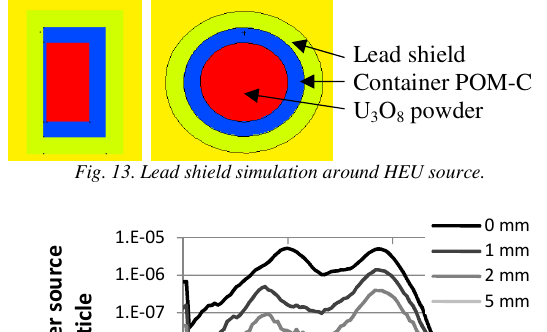
Fig. 12. Background spectra for 122s acquisitions.